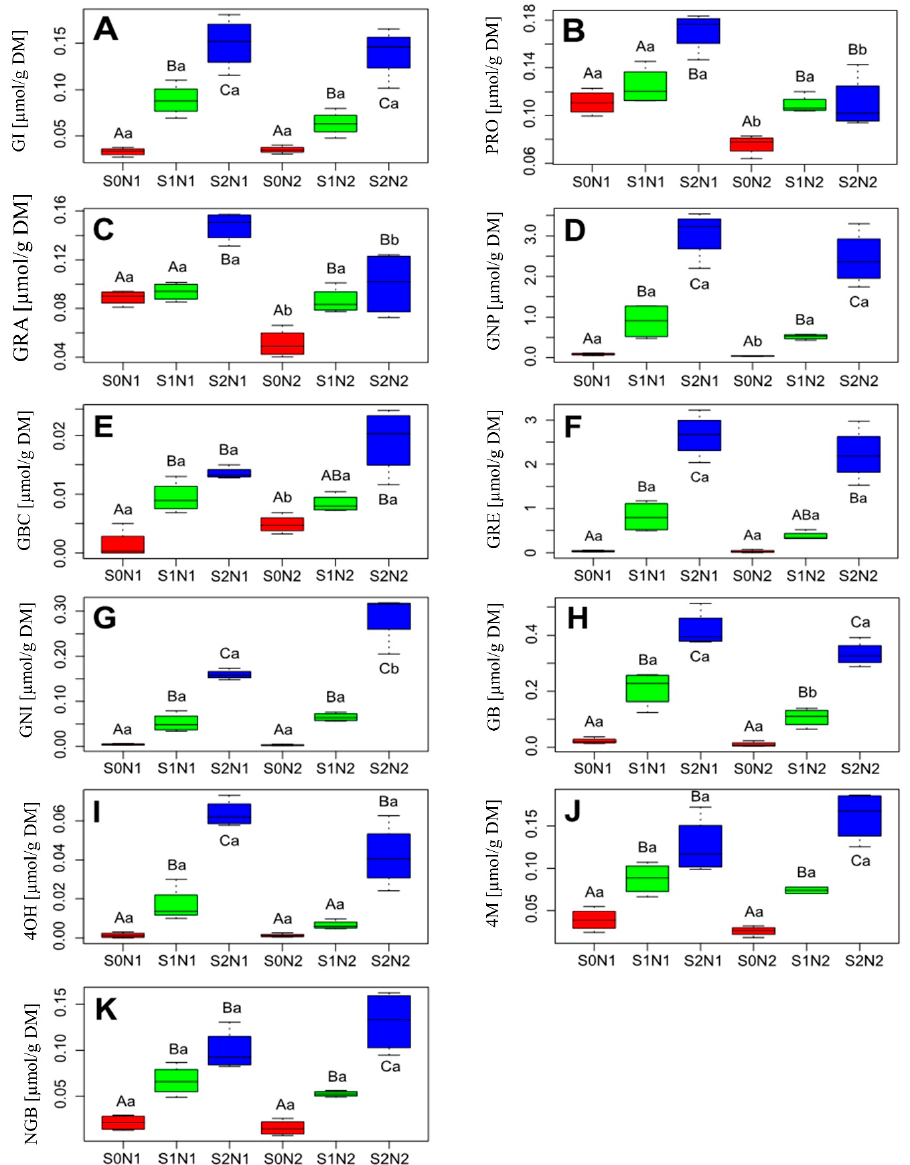
Fig. 4: Effect of S and N supply on the glucosinolate pattern: glucoiberin; GI (A), progoitrin; PRO (B), glucoraphanin; GRA (C), gluconapin; GNP (D), gluco- brassicanapin; GBC (E), glucoraphanin; GRE (F), gluconasturtiin, GNI (G), glucobrassicin, GB (H), 4-hydroxyglucobrassicin; 4OH (I), 4-methoxyglu- cobrassicin, 4M (J), neoglucobrassicin, NGB (K). Lower- and uppercase letters indicate significantdiff,erence (p<0.05) between means owing to effect of N and S supply respectively, S0 = 0 g S, S1 = 0.06 g S, S2 = 0.3 g S, N1 = 0.75 g N, N2 = 1.5 g